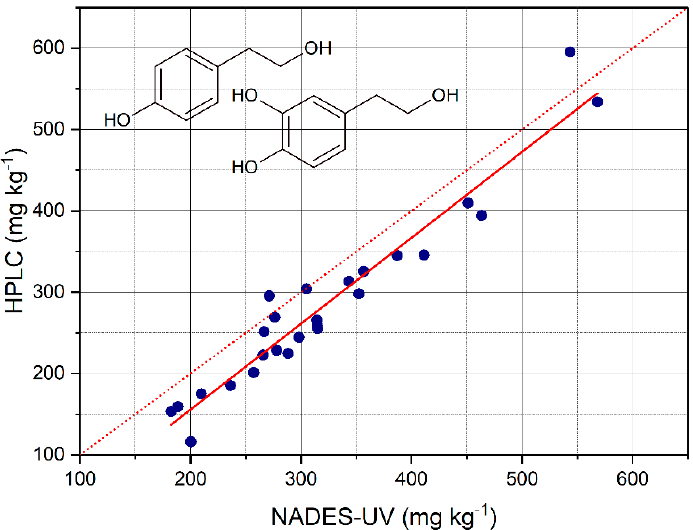
Figure 7. C ontents of total OHTyr + Tyr determined by HPLC after hydrolysis of the extracts plotted versus the contents of total OHTyr + Tyr determined by NADES extraction and UV analysis. The red dotted line has the function y = x, the red solid line is the fitted regression.